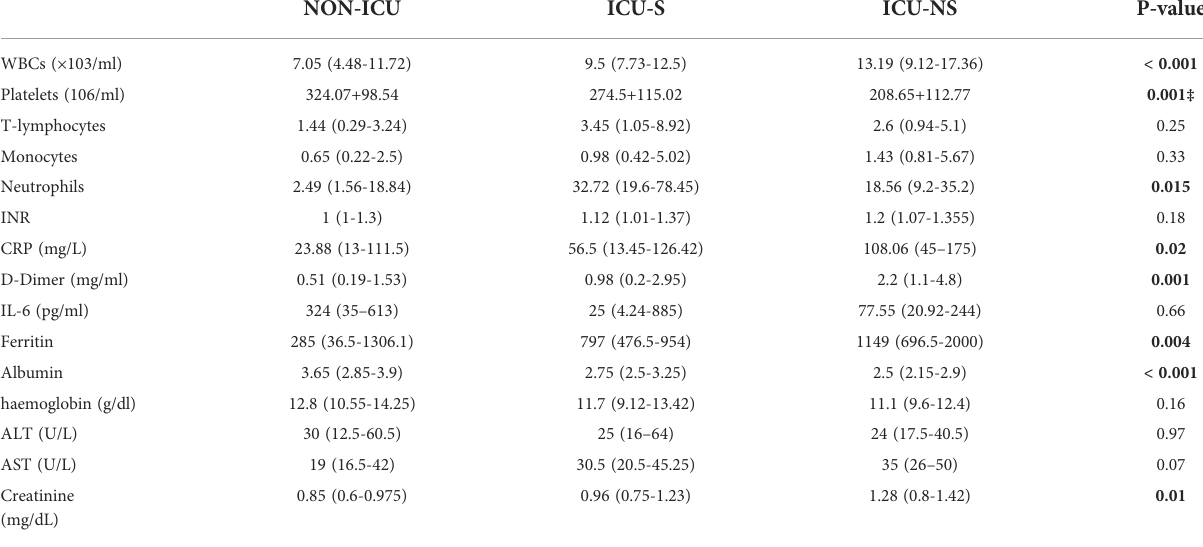
TABLE 3 Laboratory results of participants.